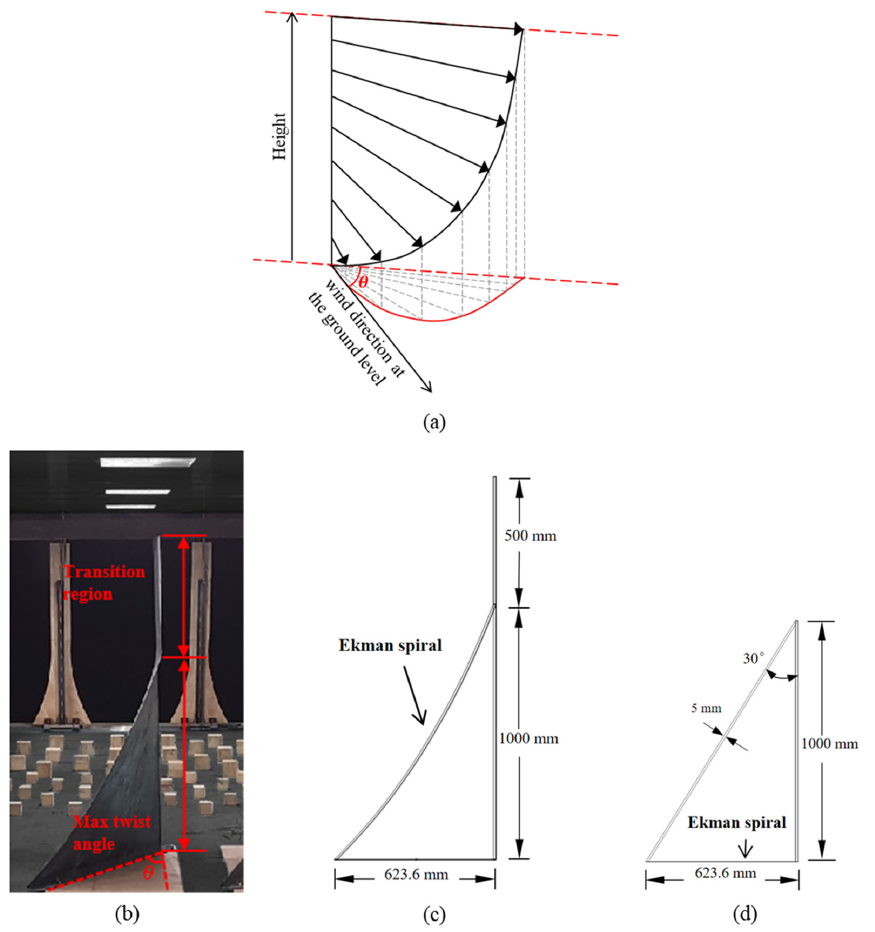
Figure 1. Guide vane system in wind tunnel: ( a ) schematics of twisted wind profile; ( b ) photo of experimental setup; ( c ) Elevation view; ( d ) top view.